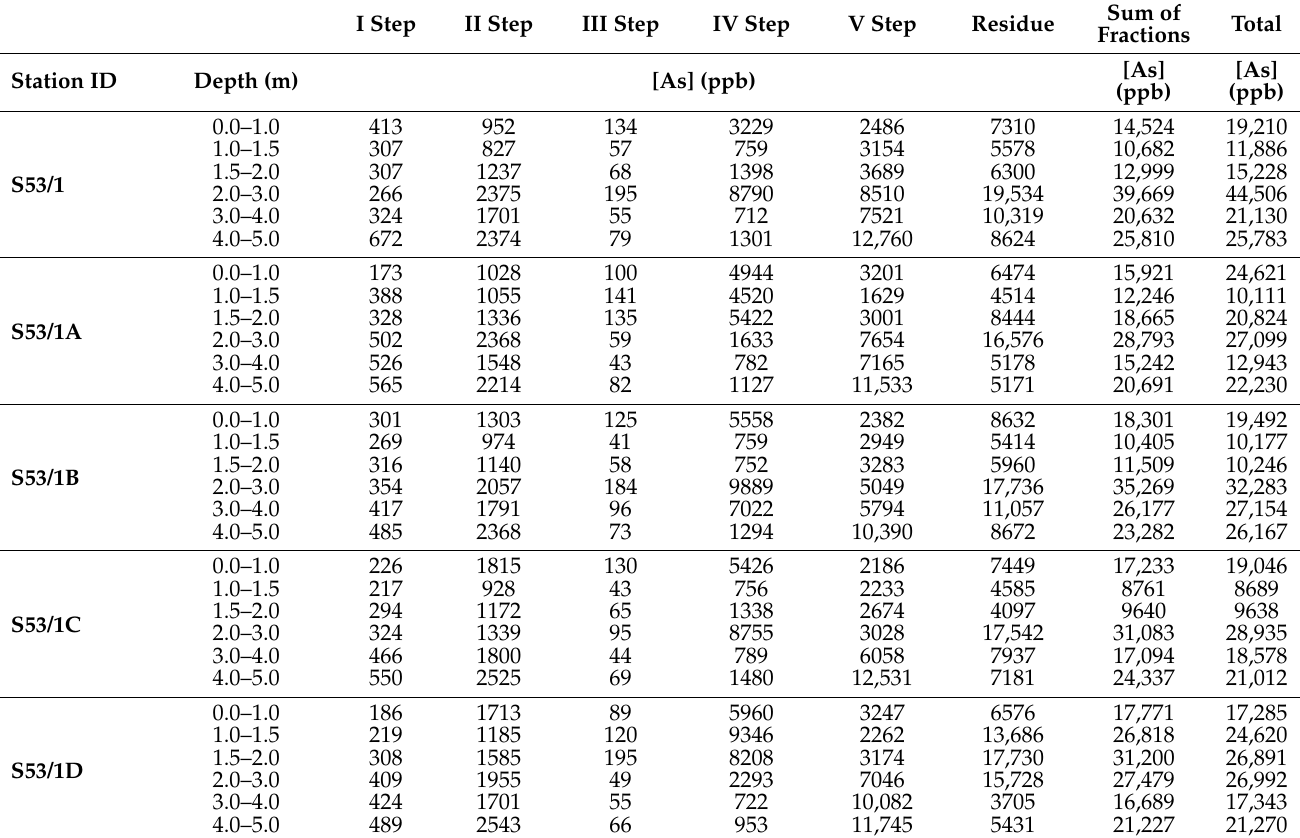
Table 4. Results from sequential extraction of As for point S53 and the close surroundings. The reported values are in ppb ( µ g/kg dry